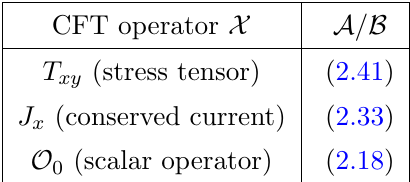
Table 1 . Where to (cid:12)nd our main results for the ratio of coe(cid:14)cients expansion of in CFTs, hXXi